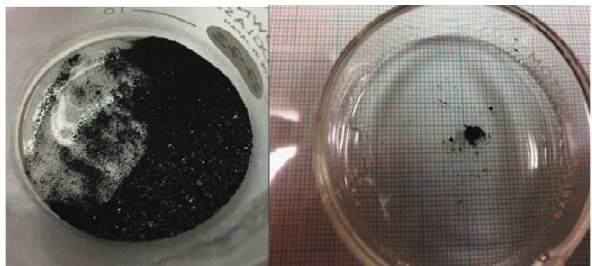
Figure 6. Th e product of the zwitterionic synthesis dry product (on left ) and the aft er 24 hours water-swelling (on